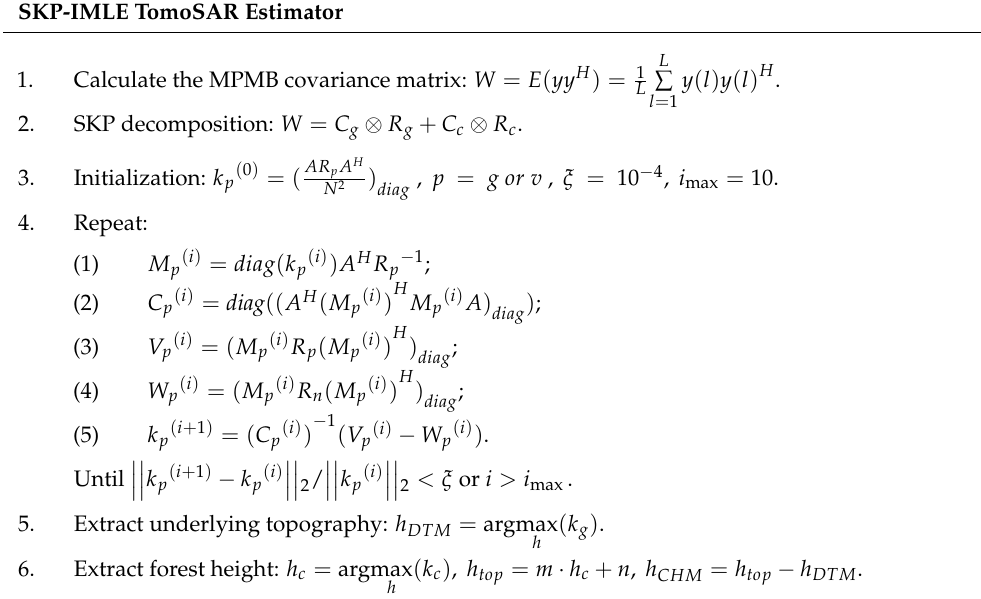
Table 1. Details of the sum of Kronecker products (SKP) decomposition and iterative maximum likelihood estimation (SKP-IMLE) estimator. TomoSAR: synthetic aperture radar tomography.